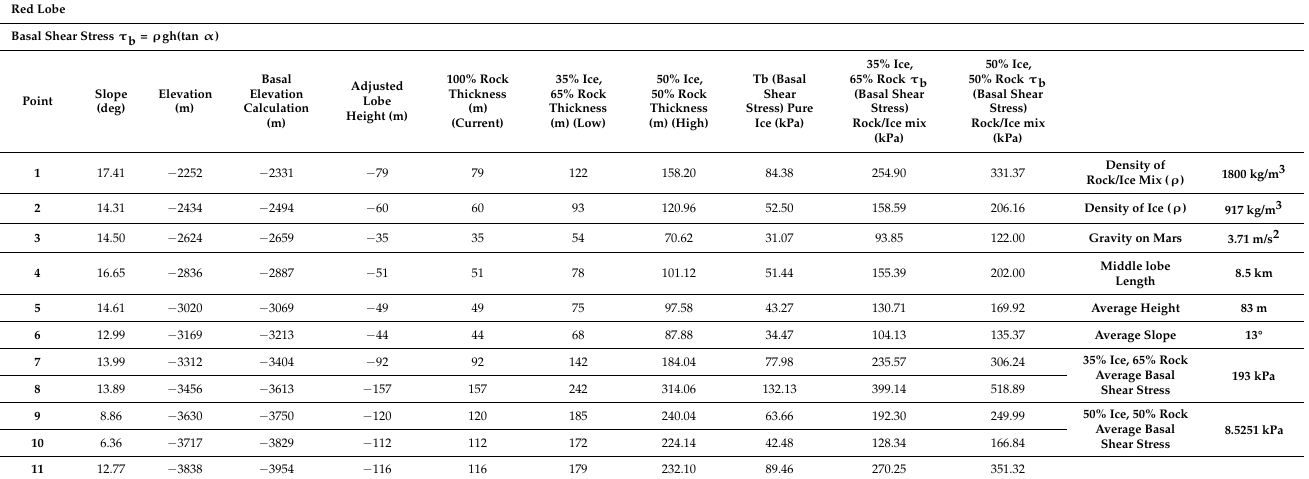
Table 1. Basal Shear Stress data for the Red (1) lobate feature shown in Figure 12a. Points 1–11 correspond to sites where flow rates were estimated (see Figure 6 for locations). Slope outliers may exist due to sampling issues, such as automated regular spacing to remove heads up vectorization sampling bias.